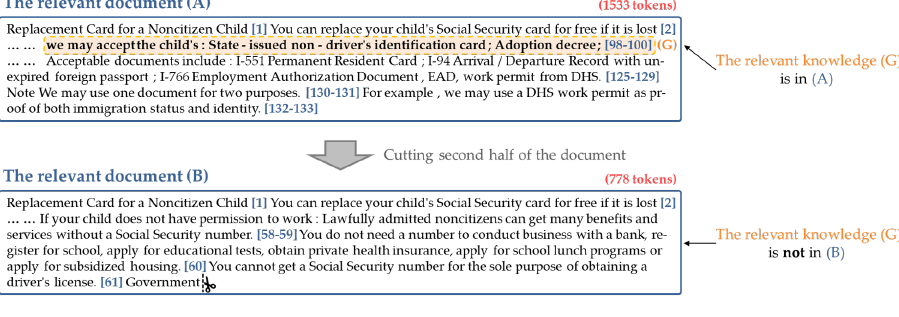
Figure 1. Process of truncating the relevant document.